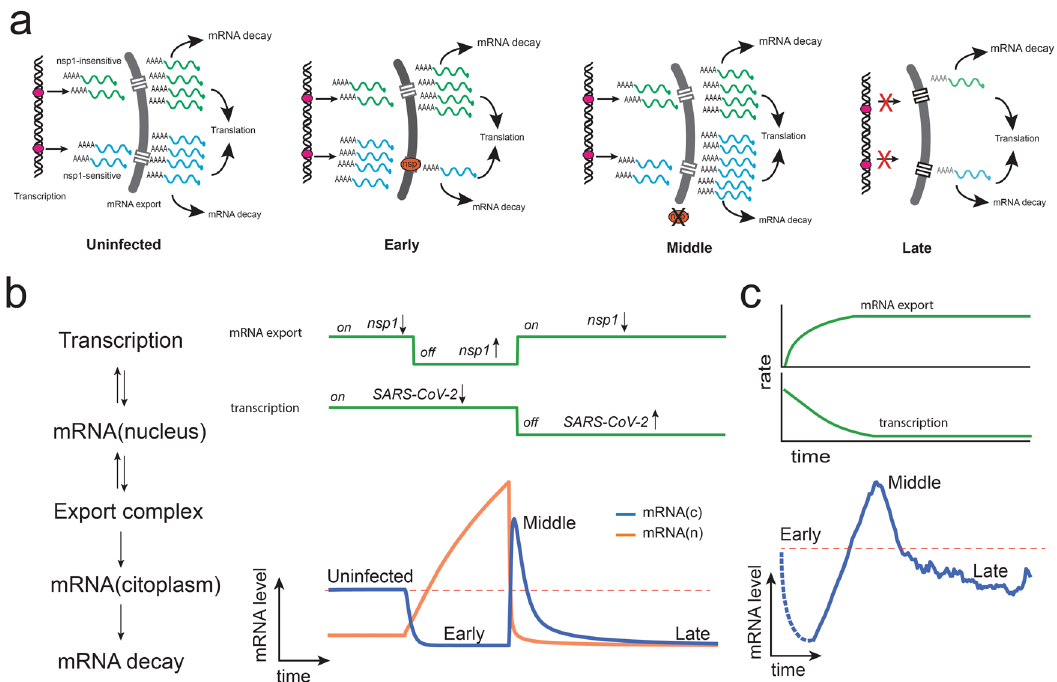
Fig. 7 Proposed model to explain the transcriptional response of infected cells to SARS-CoV-2 infection. a Selective nuclear export of nsp1-sensitive transcripts will result in the degradation of cytoplasmic mRNAs and their accumulation in the nucleus. Once the blockage is removed, retained transcripts are released, resulting in a rapid increase in cytoplasmic mRNA levels. A shutdown of transcription during the late infection stage will result in a global decrease of host mRNAs. b A simpli fi ed dynamical model simulating nuclear mRNA export and transcription as on/off switches is enough to model the mean transcriptional pro fi le. c Reinterpretation of the mean transcriptional pro fi le of hBECs. In contrast to the on-off switch model presented in panel b , it is most likely that the shutdown of transcription and nuclear export occurs gradually, as shown in the upper panel. The dotted lines represent early infection states that could not be detected in the present